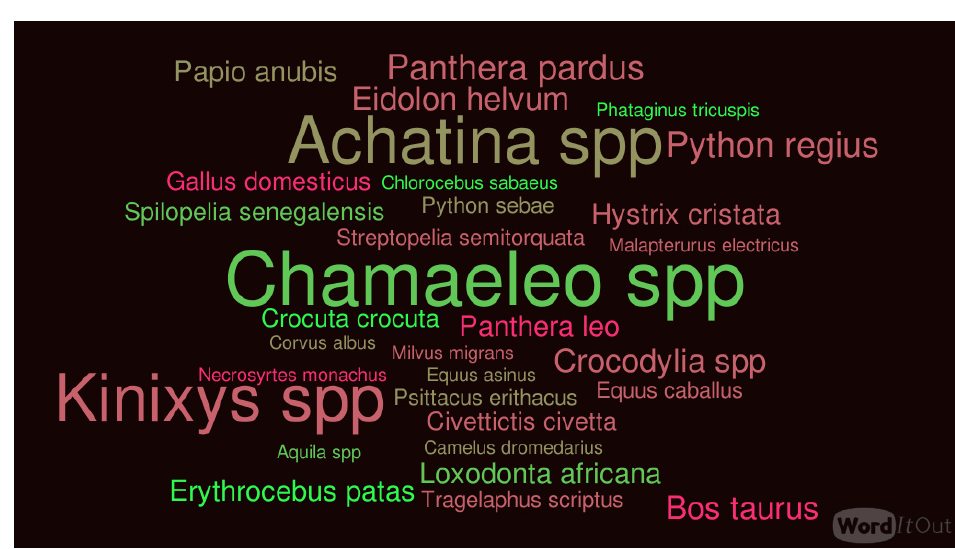
Figure 2. Word cloud of the animal species mentioned by traders as being sold for traditional medicine in the Kumasi Central Market. The size of the words is proportional to the number of times that trade was attributed to each animal. Maximum mentions are 18 for chameleon.